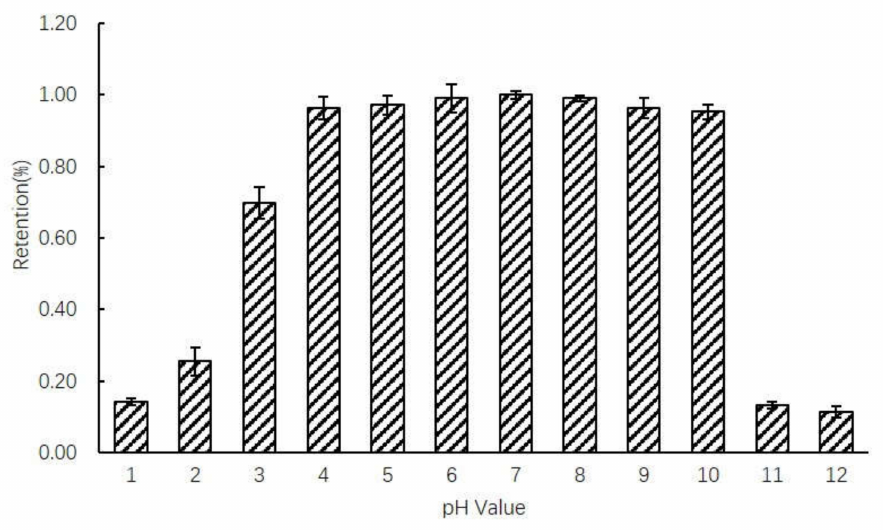
Figure 1. The impact of autoclave sterilization on the stability of